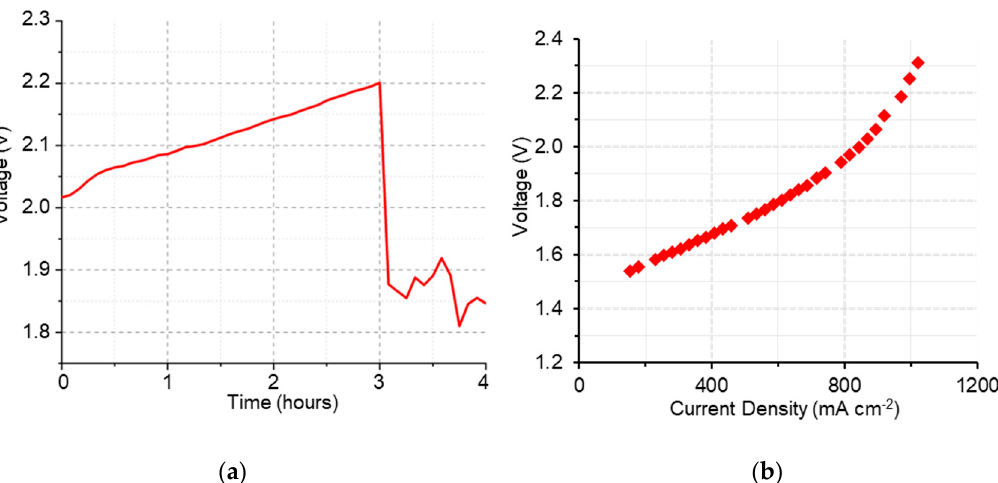
Figure 9. Durability (a) and polarization (b) curves of g-VBC-5- co -Sty-16-Q membrane during electrolysis test.